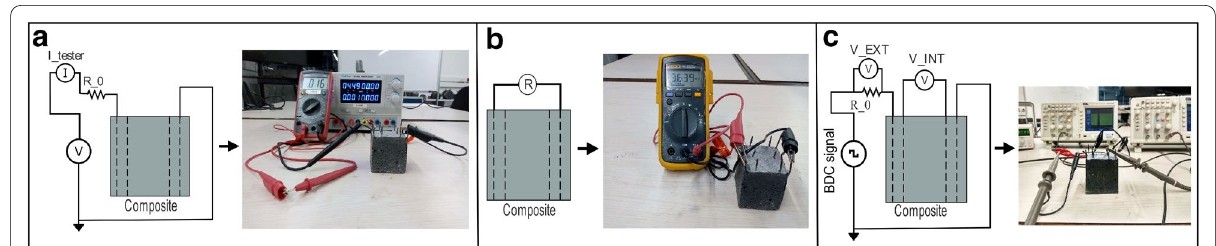
Fig. 3 a Electrical connection diagram for ohmic characterization of the CBM/CNT. b Electrical connection diagram for characterization of the electrical resistance using DC source. c Electrical connection diagram for characterization of the electrical resistance using